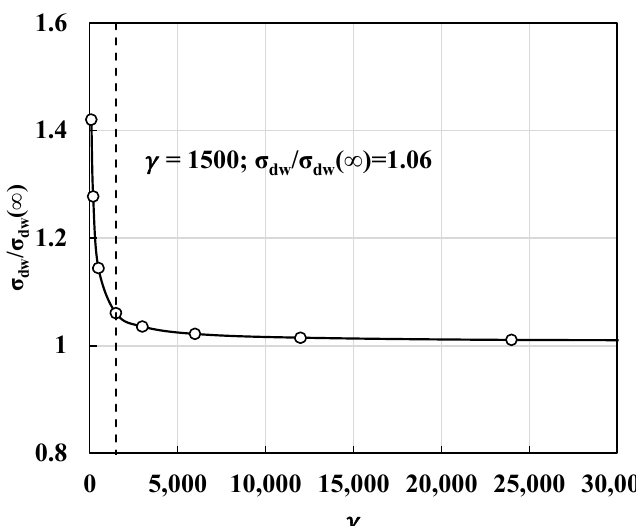
upper flanges, lower flange, and web, respectively; 𝐻 is the web height; and 𝑡 (cid:3031) is the intermediate diaphragm thickness.